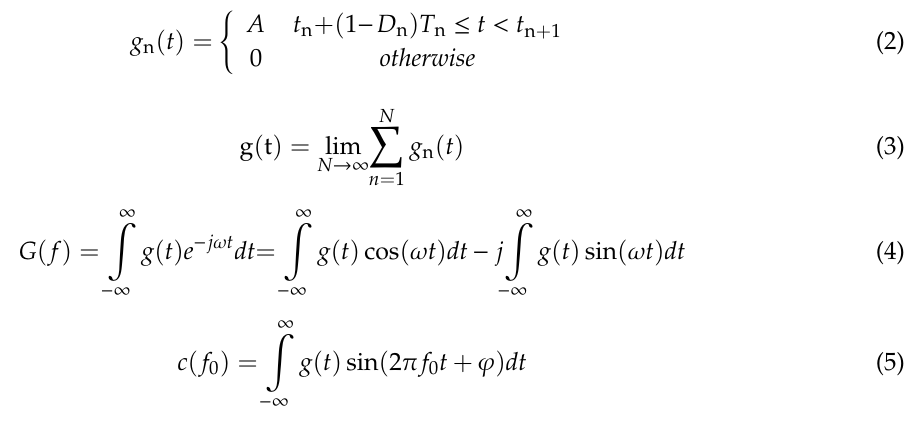
Figure 3. Topology of single-phase voltage source inverter.